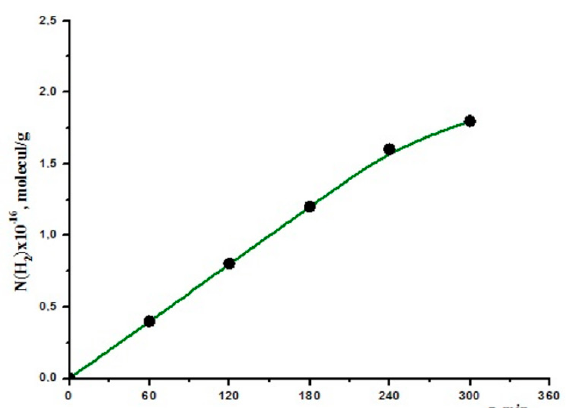
Figure 2. Kinetics of molecular hydrogen of seawater decomposition without catalyst at Т = 300 K, D = 1.05 Gy/s. D = 1.05